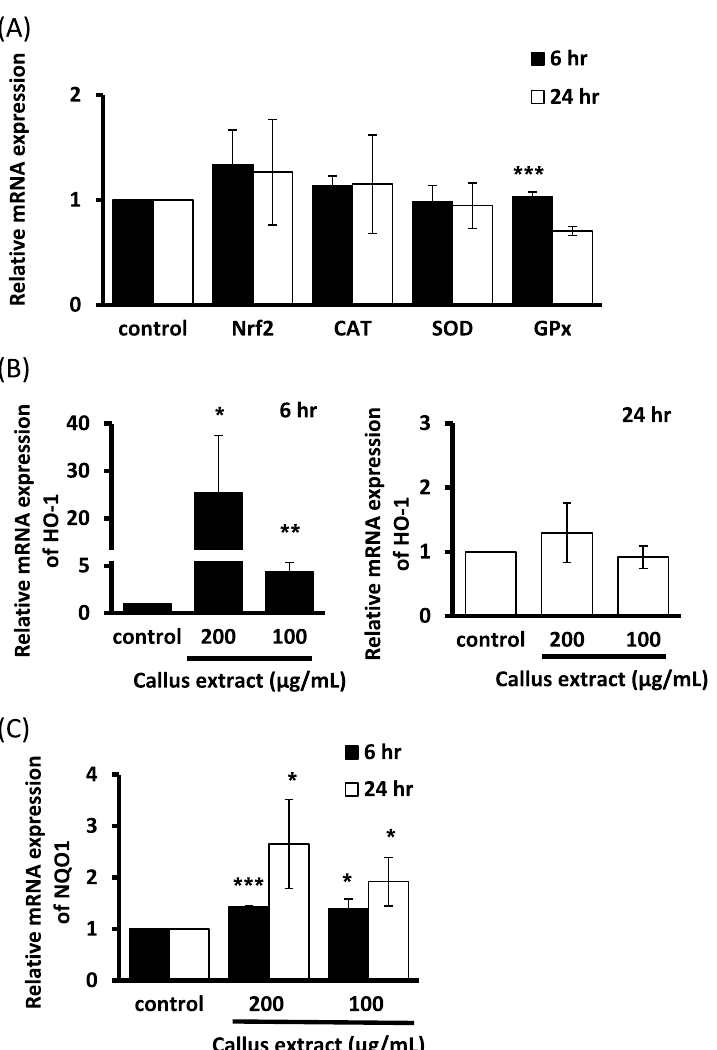
Fig. 4 The mRNA expression levels of antioxidant genes were measured in Hs68 fibroblast cells. A mRNA expression levels of four antioxidation‑related genes, Nrf2, CAT, SOD, and GPx, in cells treated with 200 μg/mL of callus extract for 6 h and 24 h. B HO‑1 mRNA expression in cells treated with 100 μg/mL and 200 μg/mL for 6 h and 24 h. C NQO1 mRNA expression in cells treated with 100 μg/mL and 200 μg/mL for 6 h and 24 h. Data are presented as means SD of triplicate experiments. * p < 0.05, ** p < 0.01, and *** p < 0.001 compare with ±